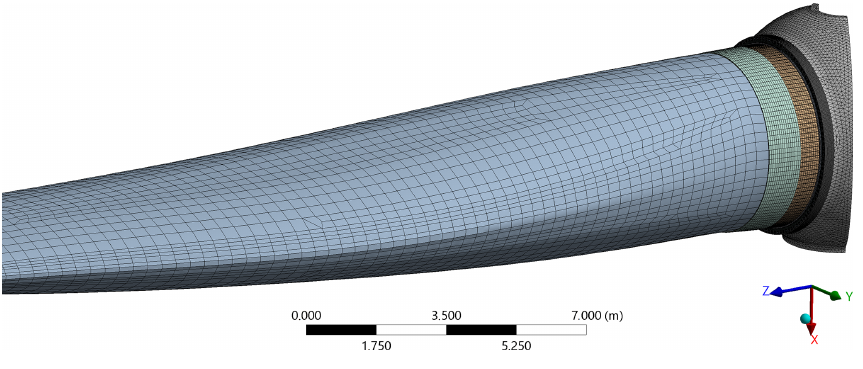
Figure 1. FE model of blade, bearing, and hub.